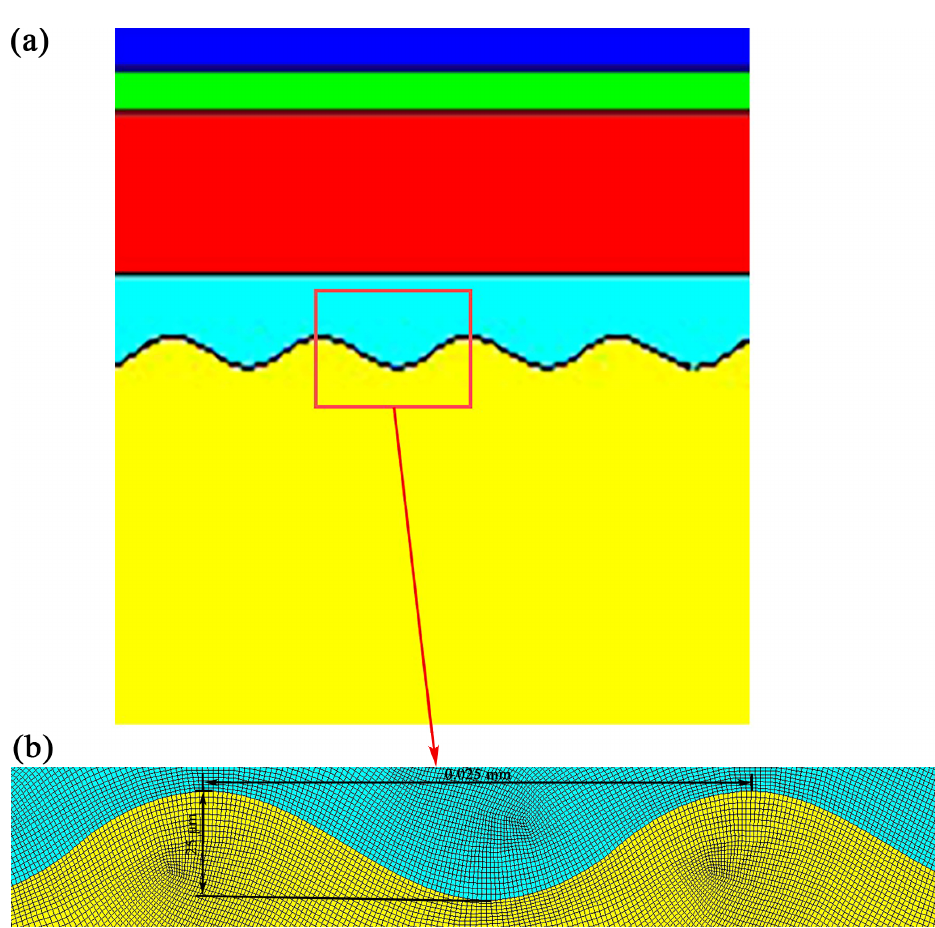
Figure 2. Numerical models: ( a ) simple physical model; ( b ) finite element model and mesh and ( c ) local magnification of model 2b.